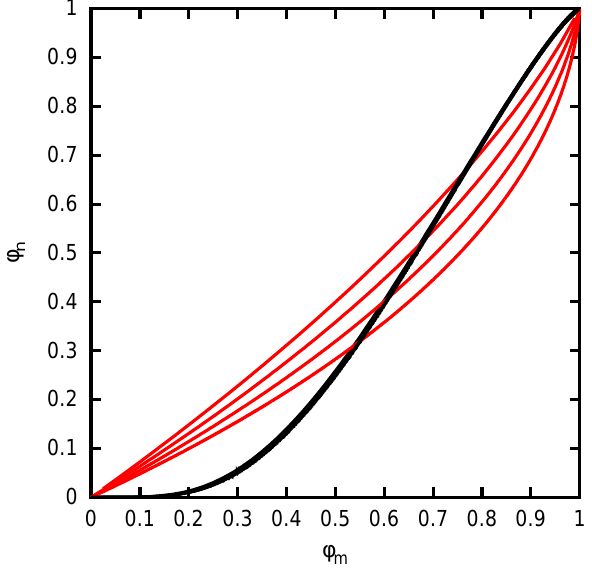
Fig. 6. φ n vs. φ m , as parameterized in Spichtinger and Gierens (2009) (red lines, for various choices of sublimation rates and initial geometric mean masses), compared with the analytical solution for various initial geometric mean masses and sublimation rates (black line). Only one black line can be seen because the differences be- tween the analytical solutions are smaller than the thickness of the curve. and f n = [cos(( f m − 1) π ) + 1] / 2 . This did not yield real